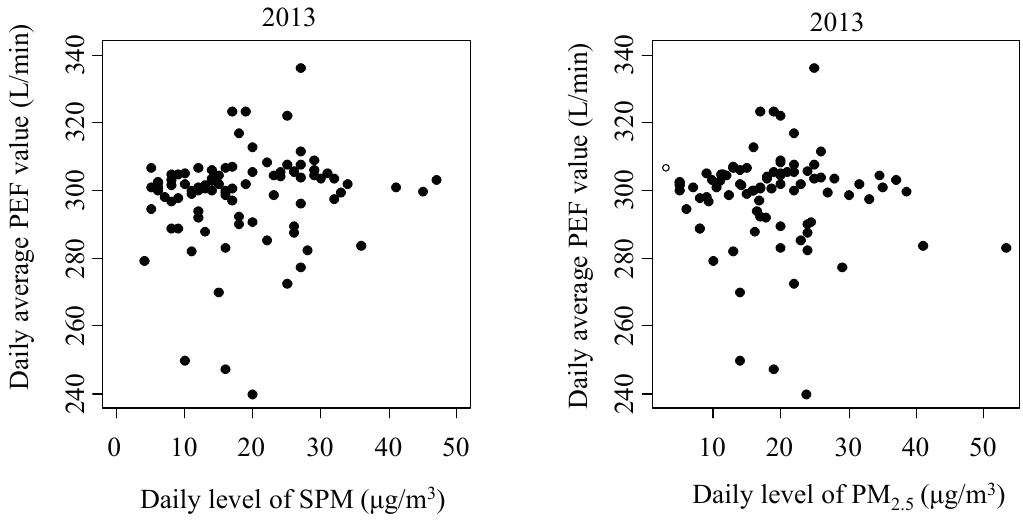
Figure 2. The associations of daily average peak expiratory flow (PEF) values and daily levels of suspended particulate matter (SPM) and particulate matter smaller than 2.5 μ m in diameter (PM 2.5 ) in the 2012 and 2013 surveys.